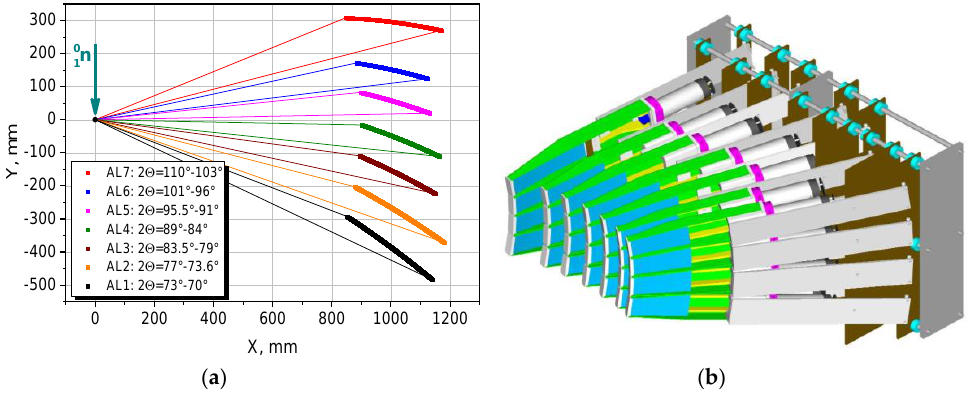
Figure 5. ( a ) Arrangement of sensitive ZnS(Ag) scintillator layers of the multi-element ASTRA 90°-detector in the horizontal scattering plane; ( b ) 3D model of the ASTRA 90°-detector, adapted from [25], with permission from © 2010 Springer.